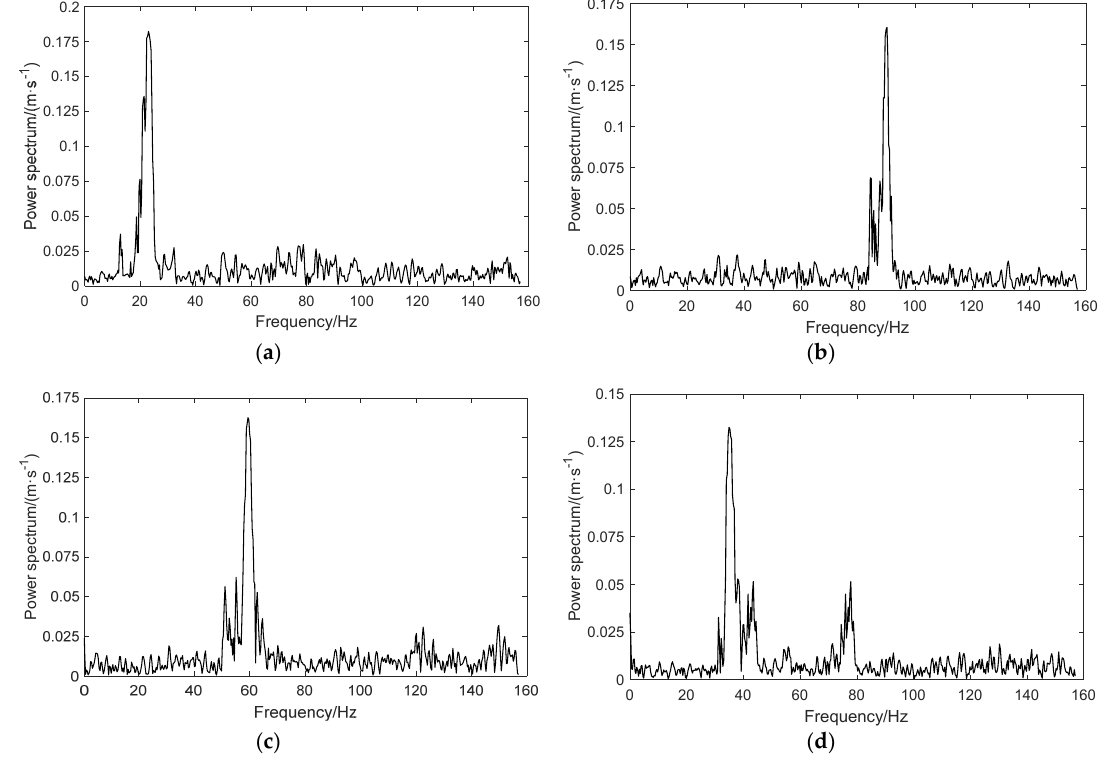
Figure 13. The frequency spectrum of four measuring points after optimization. ( a ) measuring point 1, ( b ) measuring point 2, ( c ) measuring point 3, and ( d ) measuring point 4. Appl. Sci. 2019 , 9 , x